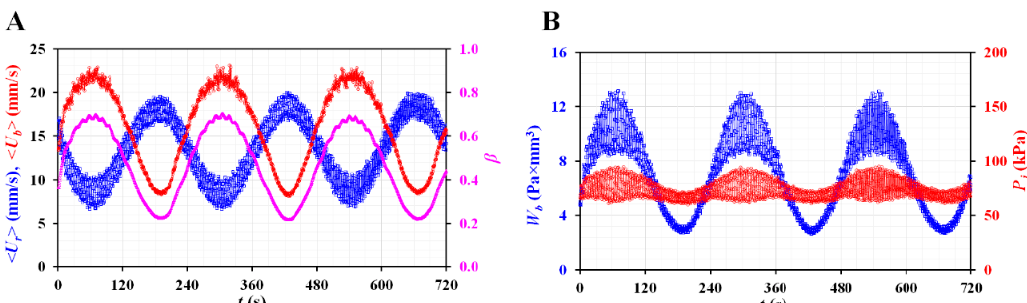
Figure 5. Quantitative evaluations of two biophysical properties (i.e., junction pressure and pressure-induced work) under periodic blood flow. Using a syringe pump, blood flow rate ( Q b ) was supplied as Q b ( t ) = 3 + 2 sin (2 × π × t /240) mL/h. ( A ) Variations of < U r >, < U b >, and β with an elapse of time. ( B ) Temporal variations of P j , and W b .